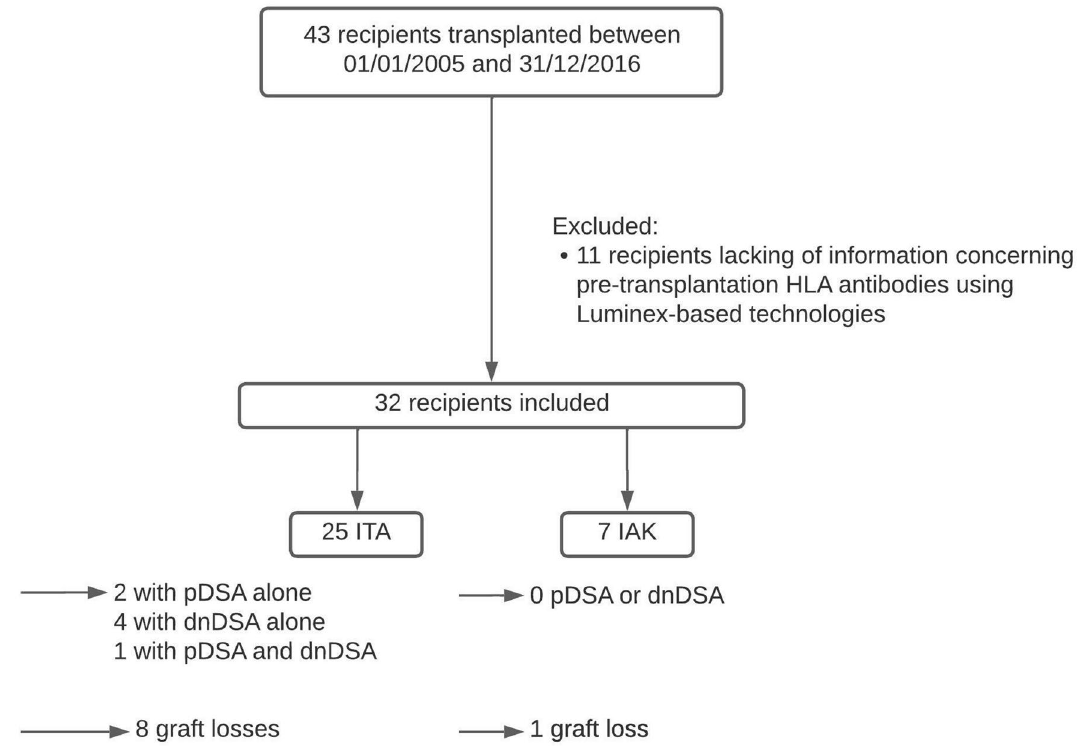
Figure 1. Flow-chart of the study. ITA islet-transplantation alone; IAK islet-after-kidney; pDSA preformed Donor Specific Antibodies; dnDSA de novo Donor Specific